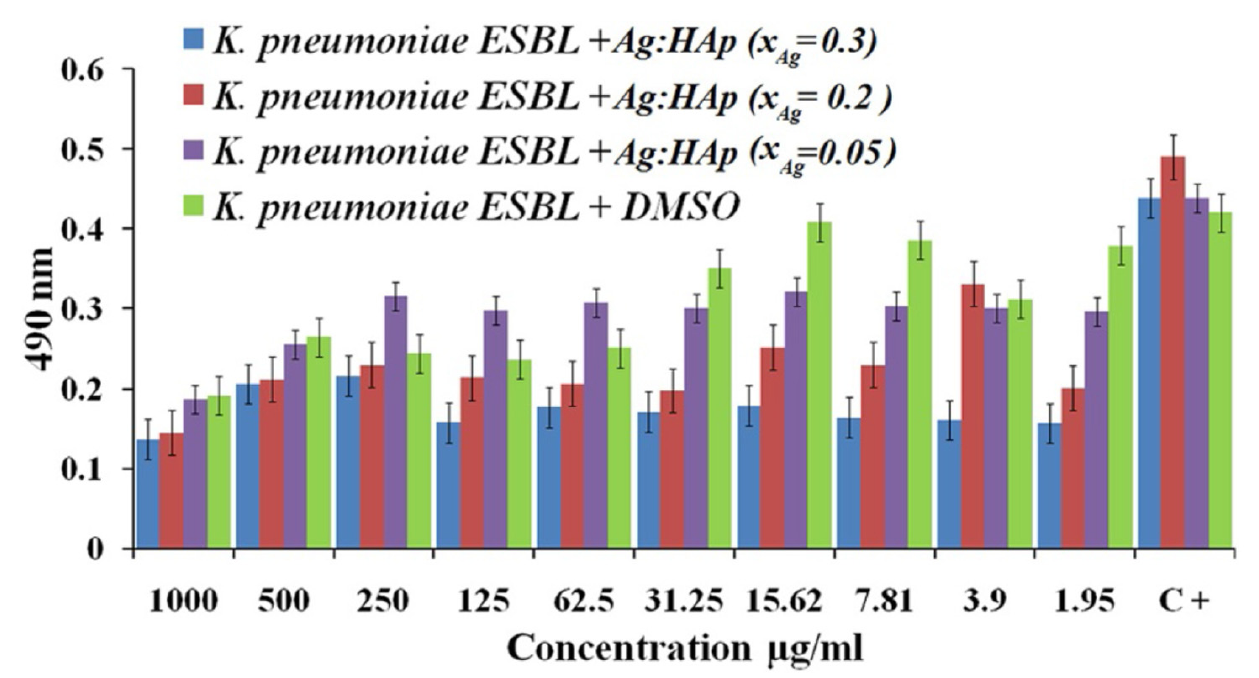
Figure 4. Antibacterial effect of Ag:Hap-NPs (xAg = 0.3, 0.2, and 0.05) on KP, adapted from [111], Springer, 2012.